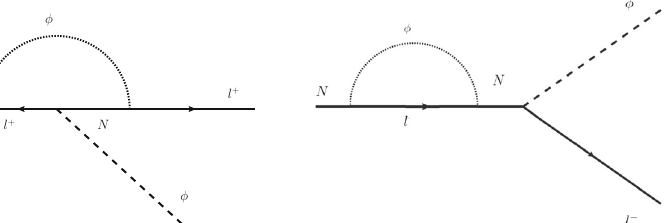
ries, with only CP violation in the lepton sector; it is necessary to have more than one generation of right-handed neutrinos, given that the CP violation appears in the neutrino mixing matrix. In this standard case the RHN N in intermediate lines in the middle and right panel graphs are understood to have a different flavour from the external RHN line. The flavours of RHN are not indicated in the diagram for brevity